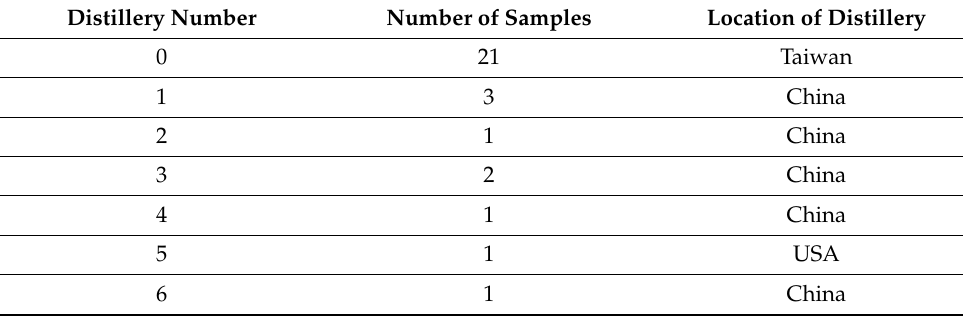
Table 1. Samples correlated to distillery and country of